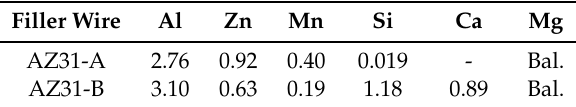
Table 2. Chemical compositions of filler wires (wt.